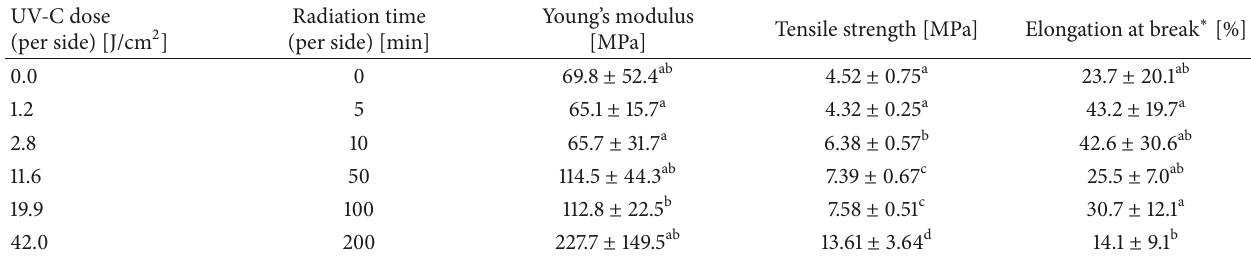
Table 2: Mechanical properties of UV-treated WPI-based films as a function of UV dose and radiation time; significant differences are indicated by different letters (𝑝 < 0.05) .